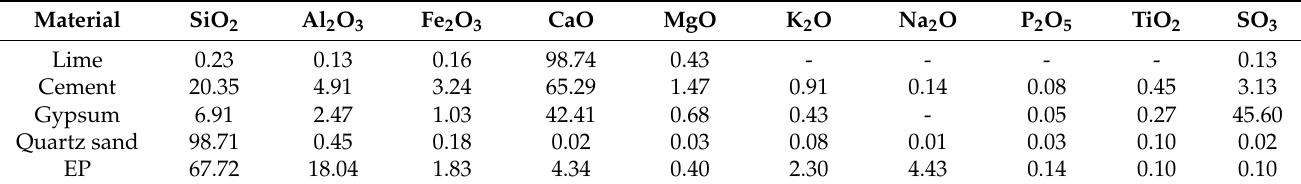
Table 3. Chemical composition of initial materials (wt.%) obtained by XRF.